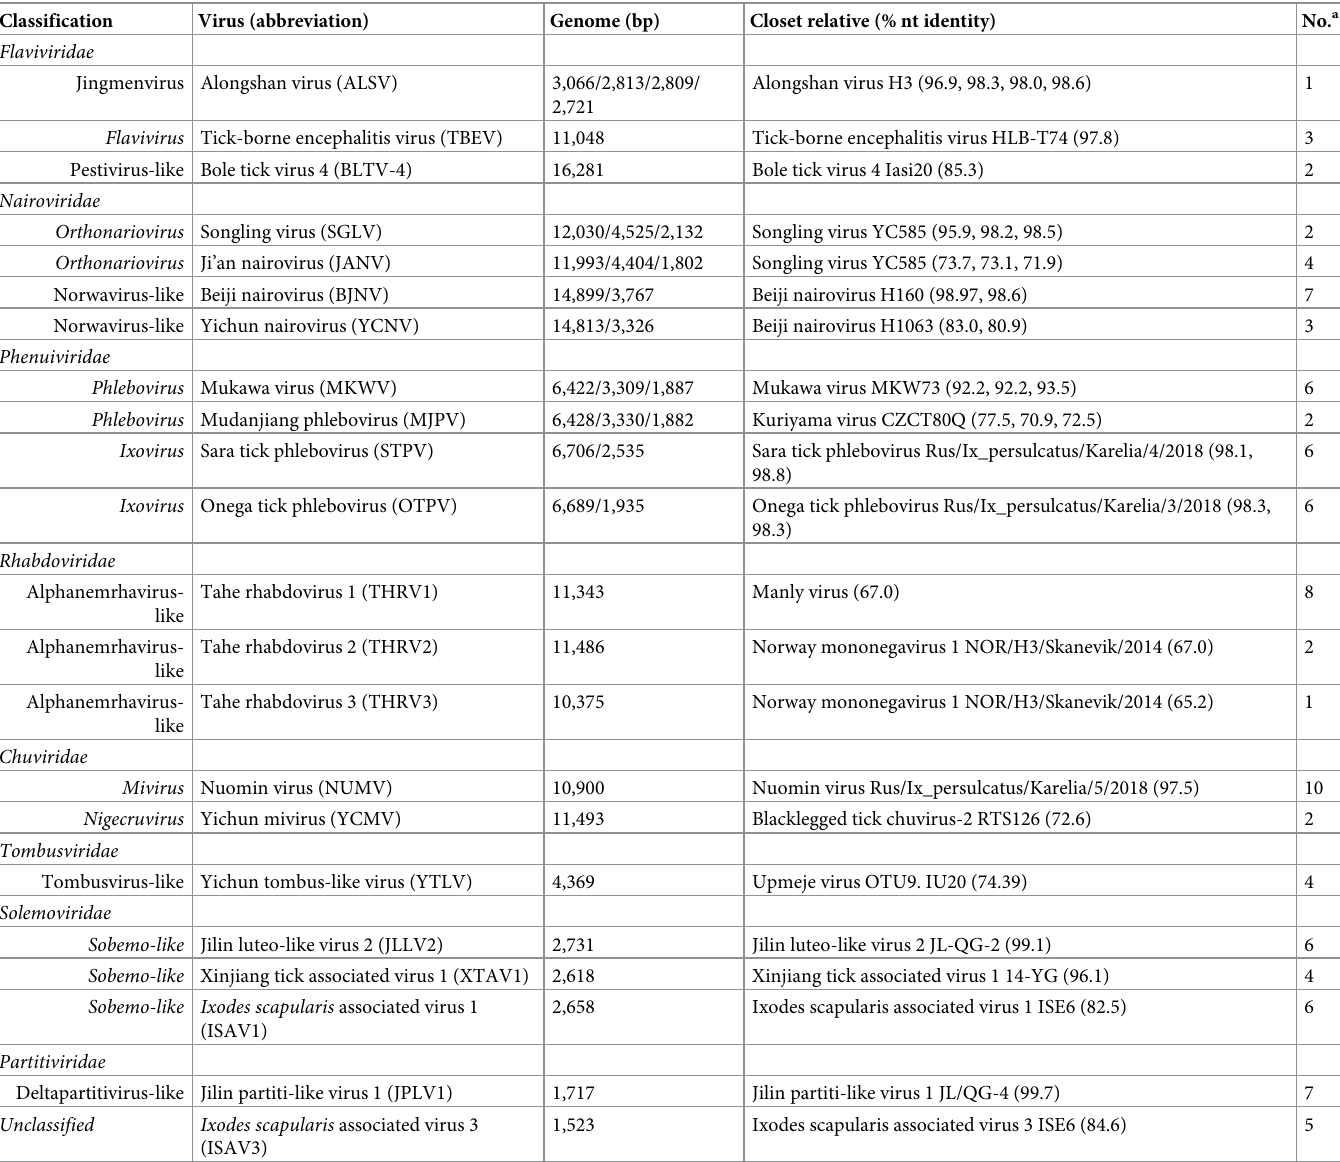
Table 1. Viruses identified in the present